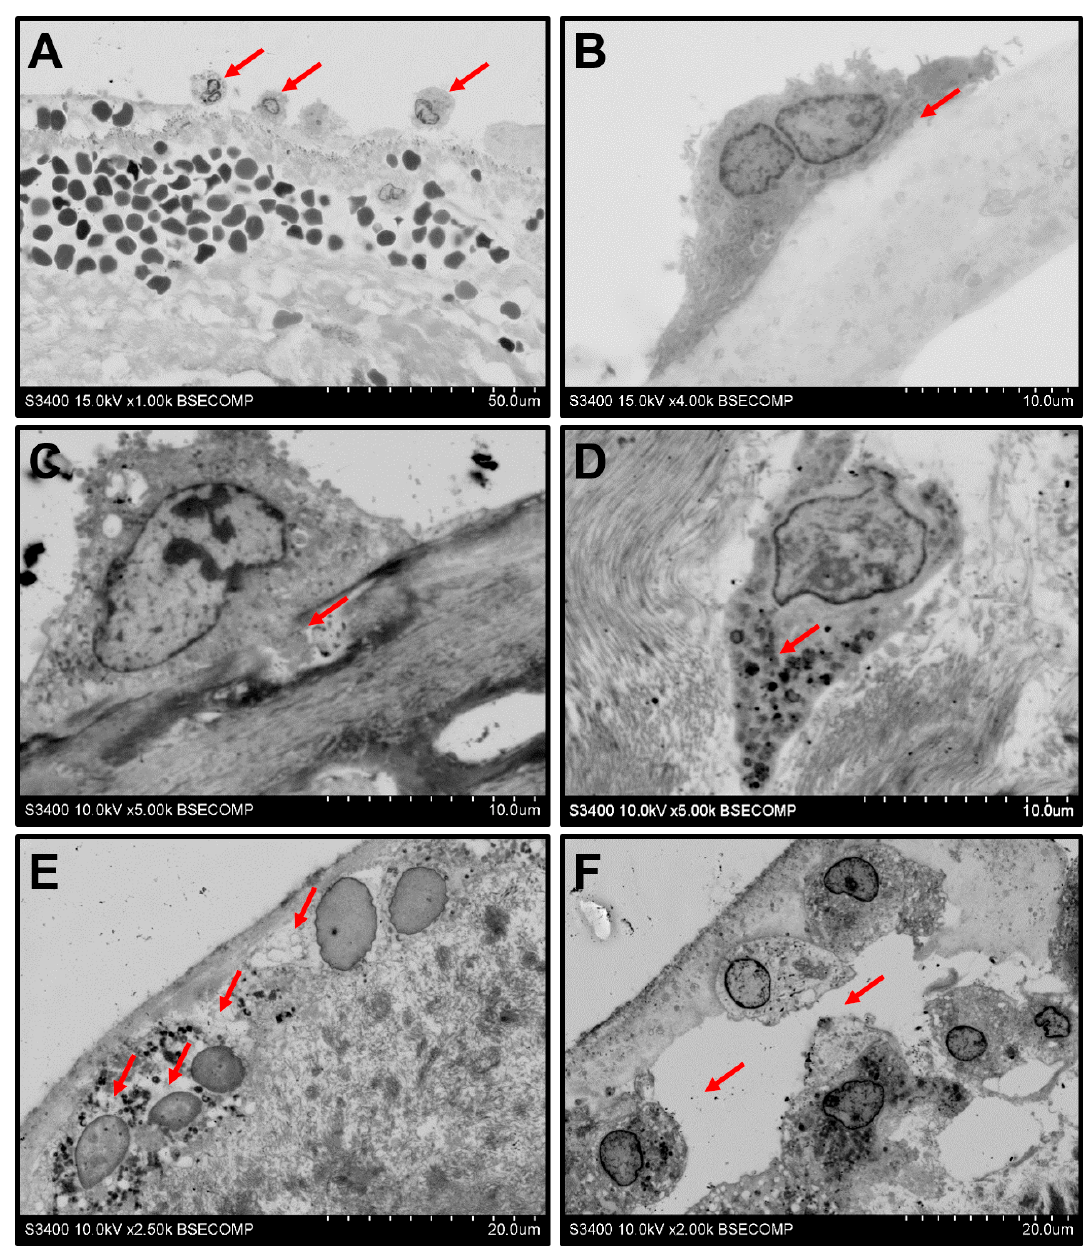
Figure 3. Events behind the monocyte infiltration of the BHVs. ( A ) Rolling of the monocytes (indicated by red arrows) along the BHV surface, magnification 1000 × . ( B ) Adhesion to the surface (indicated by red arrows), magnification 4000 × . ( C ) Cleavage of the ECM proteins and ECM degradation by invadopodia (indicated by red arrows), magnification 5000 × . ( D ) Aggregation of the cytoplasmic granules at the leading edge of the macrophage (indicated by red arrows), magnification 5000 × . ( E ) Degradation of the ECM around the macrophages (indicated by red arrows), magnification 2500 × . ( F ) Delamination of the ECM upon its degradation (indicated by red arrows), magnification 2000 ×